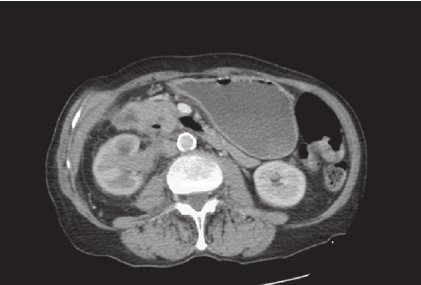
Figure 2: Axial view of the CT scan of the abdomen and pelvis showing a mass in the right renal pelvis.